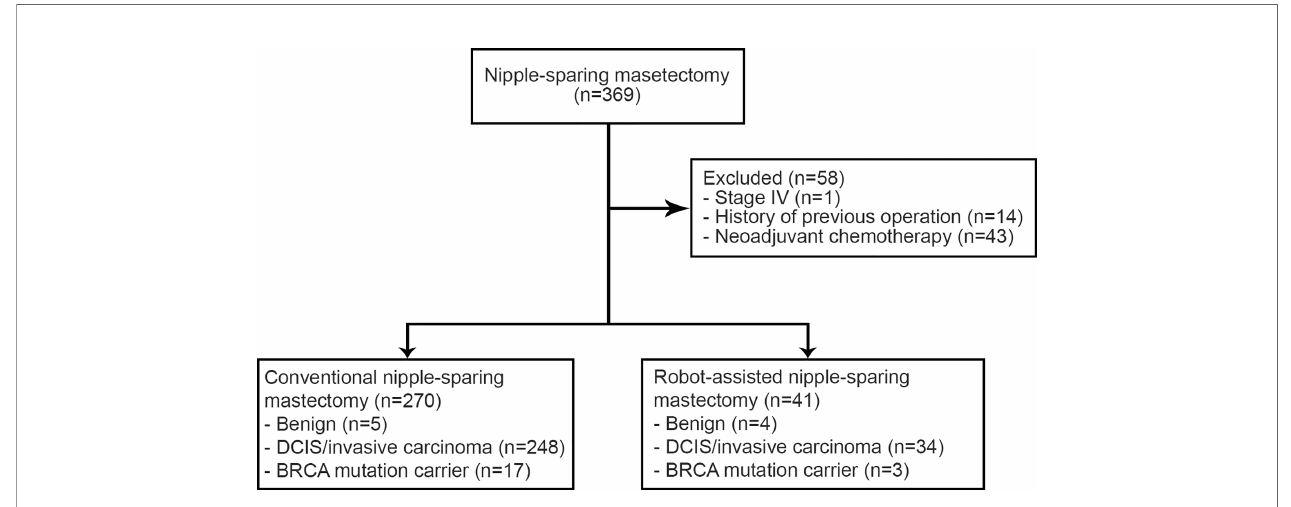
FIGURE 1 | Schematic diagram of the study